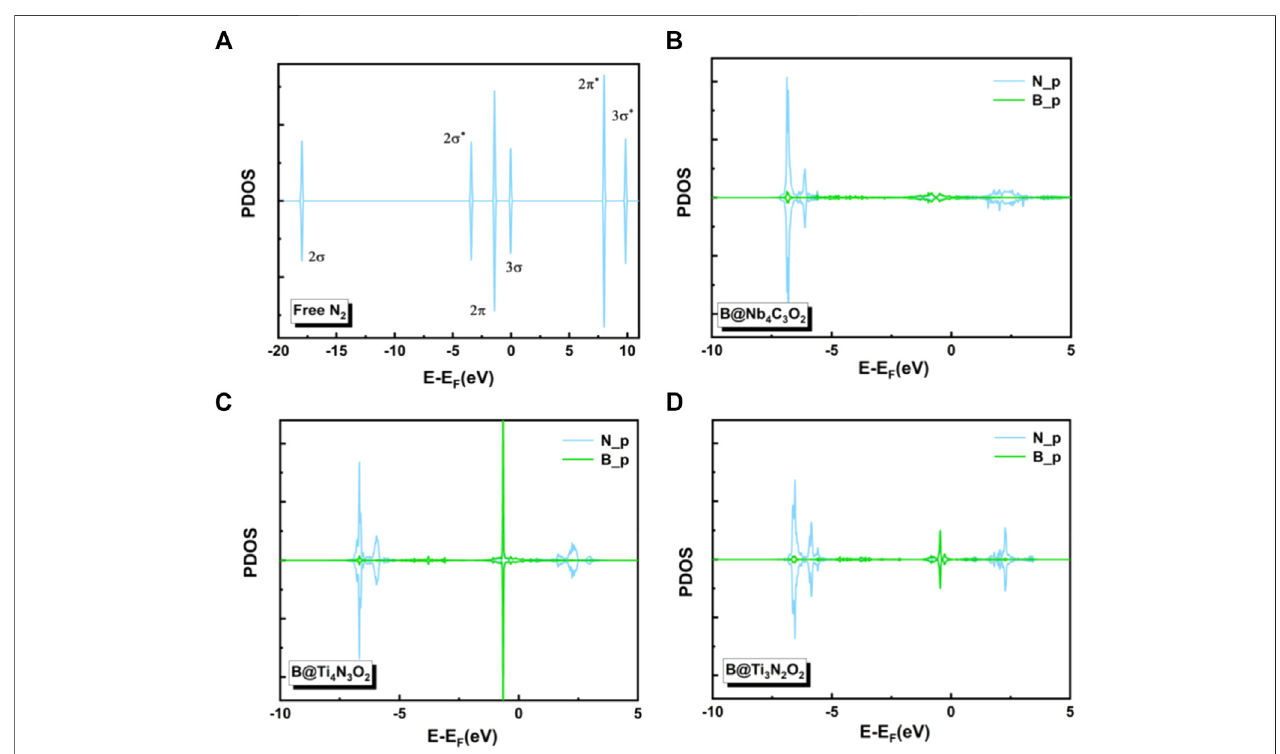
FIGURE 6 | The projected densities of states (PDOSs) of (A) free N 2 and N 2 adsorbed on (B) B@Nb 4 C 3 O 2 , (C) B@Ti 4 N 3 O 2 , and (D) B@Ti 3 N 2 O 2 surfaces.